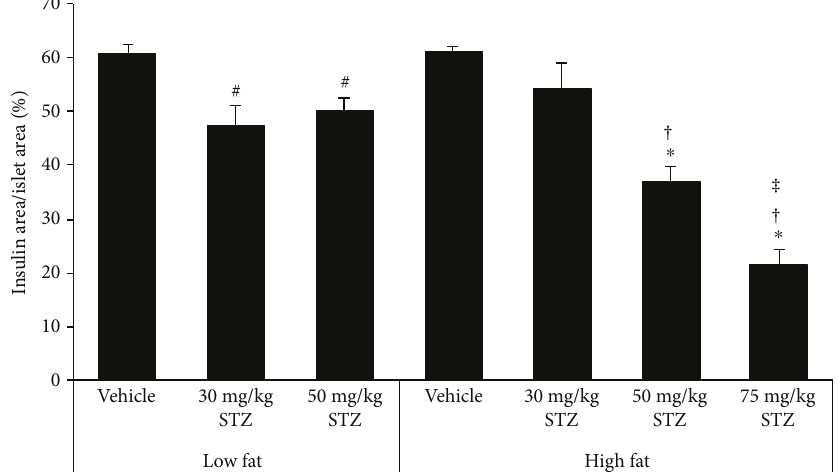
Figure 6: β -Cell area normalized to islet area, expressed as insulin positivearea/islet area × 100% , in low and high fat-fed mice treated with three consecutive once-daily doses of vehicle or 30, 50, or 75mg/kg STZ. Data are means ± SEM . Low fat — vehicle, n = 4 ; low fat — 30mg/kg STZ, n = 4 ; low fat — 50mg/kg STZ, n = 4 ; high fat — vehicle, n = 4 ; high fat — 30mg/kg STZ, n = 3 ; high fat — 50 mg/kg STZ, n = 6 ; high fat — 75mg/kg STZ, n = 3 . # p < 0 05 versus low fat — vehicle, ∗ p < 0 001 versus high fat — vehicle, † p < 0 001 versus high fat — 30mg/kg STZ, ‡ p < 0 01 versus high fat — 50mg/kg